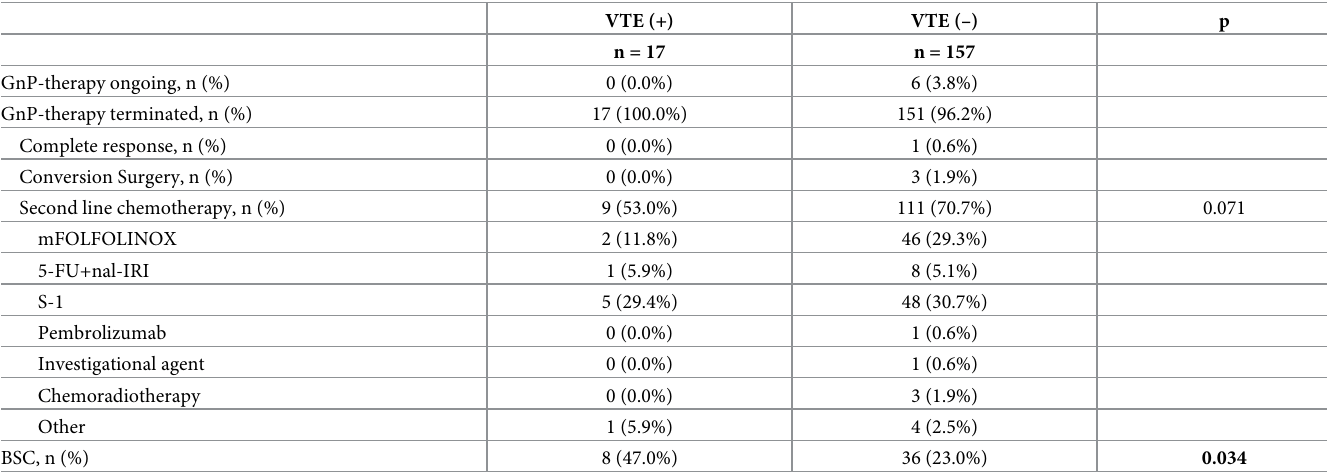
Table 4. PostGnP treatment at the time of data